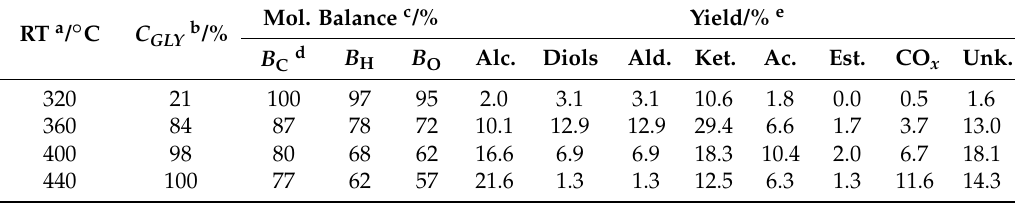
Table 2. Glycerol conversion and product distribution for reactions over CeO 2 at different temperatures.